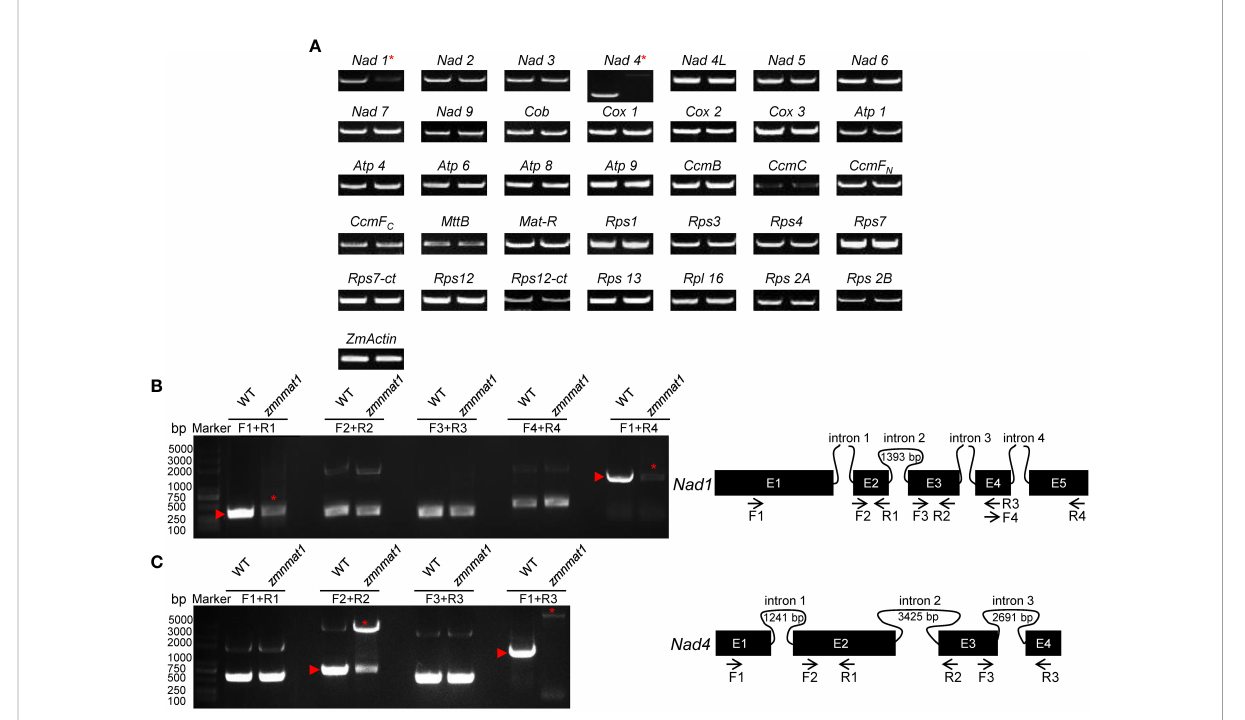
FIGURE 5 The loss of Nad1 and Nad4 mature transcripts and splicing de fi ciency of Nad1 intron 1 and Nad4 intron 2 in zmnmat1 mutant. (A) RT-PCR analysis of 35 mitochondria-encoded transcripts in 10 DAP WT (left) and zmnmat1 mutant (right) kernels. ZmActin was used as internal control. (B) RT-PCR analysis of Nad1 intron-splicing ef fi ciency in WT and zmnmat1 mutants (left) and schematic structure of Nad1 gene (right). The expected ampli fi cation products using different primer pairs are indicated (right). Red asterisks indicate the abnormal unspliced fragments and red triangles indicate the normal spliced fragments (left). (C) RT-PCR analysis of Nad4 intron-splicing ef fi ciency in WT and zmnmat1 mutants (left) and schematic structure of Nad4 gene (right). The expected ampli fi cation products using different primer pairs are indicated (right). Red asterisks indicate the abnormal unspliced fragments and red triangles indicate the normal spliced fragments